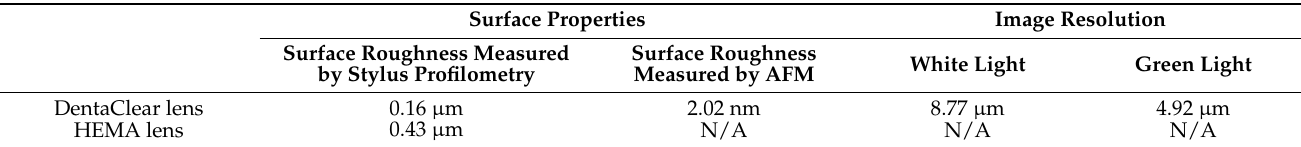
Table 2. Optical properties of the fabricated